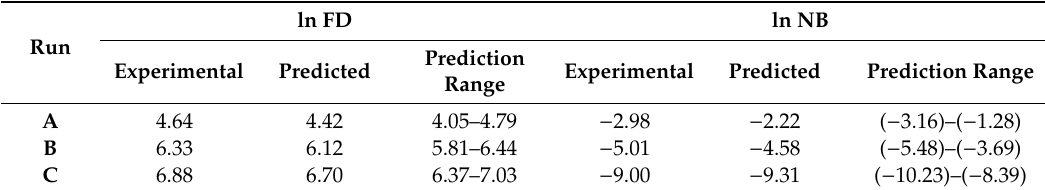
Table 1. Experimental and predicted ln fiber diameter (FD) and ln number of beads present per µ m 2 (NB) values for three experiments.